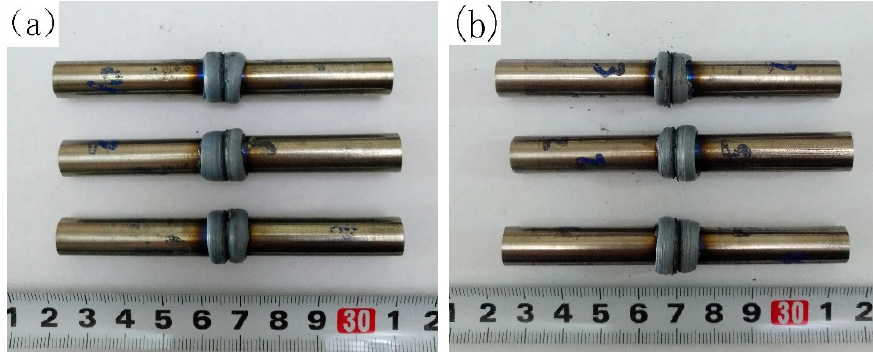
Figure 4. Welded joints of the as-cast alloy ( a ) and the as-forged alloy ( b ).